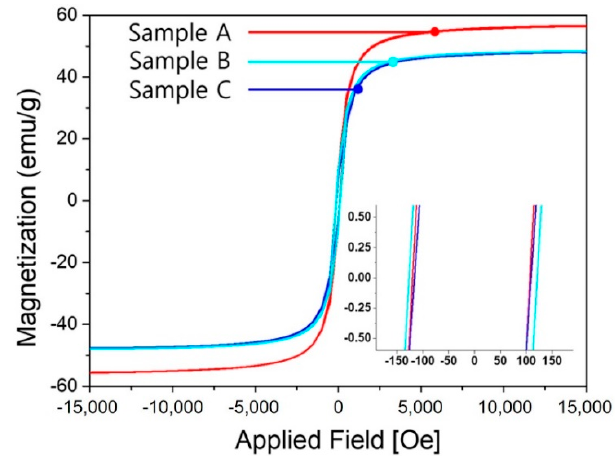
Figure 6. Magnetization versus magnetic field curves (M-H hysteresis loops) of Ni 0.5 Zn 0.5 Fe 2 O 4 nanofibers.